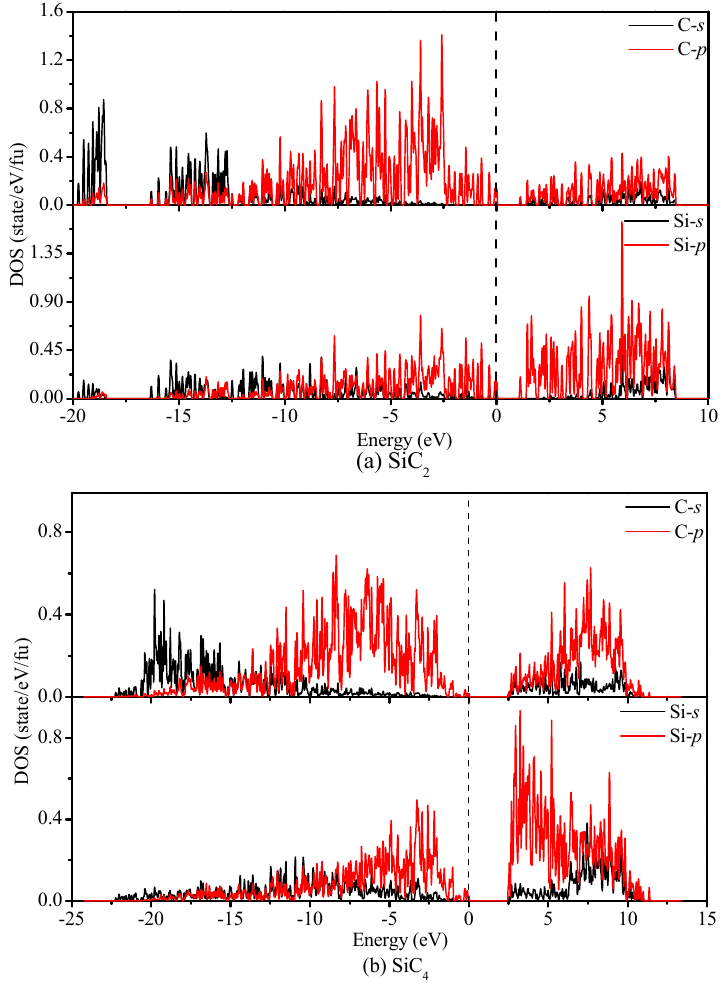
Figure 6. The partial density of states of SiC 2 ( a ) and SiC 4 ( b ).